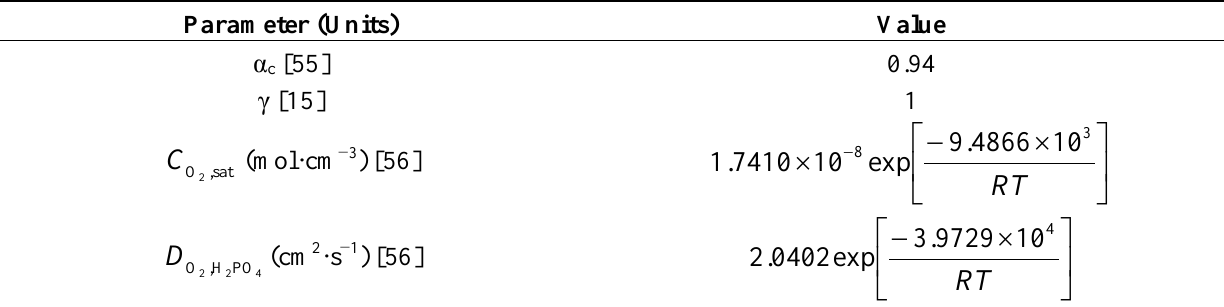
Table 1. Parameters used in Equations (5) and